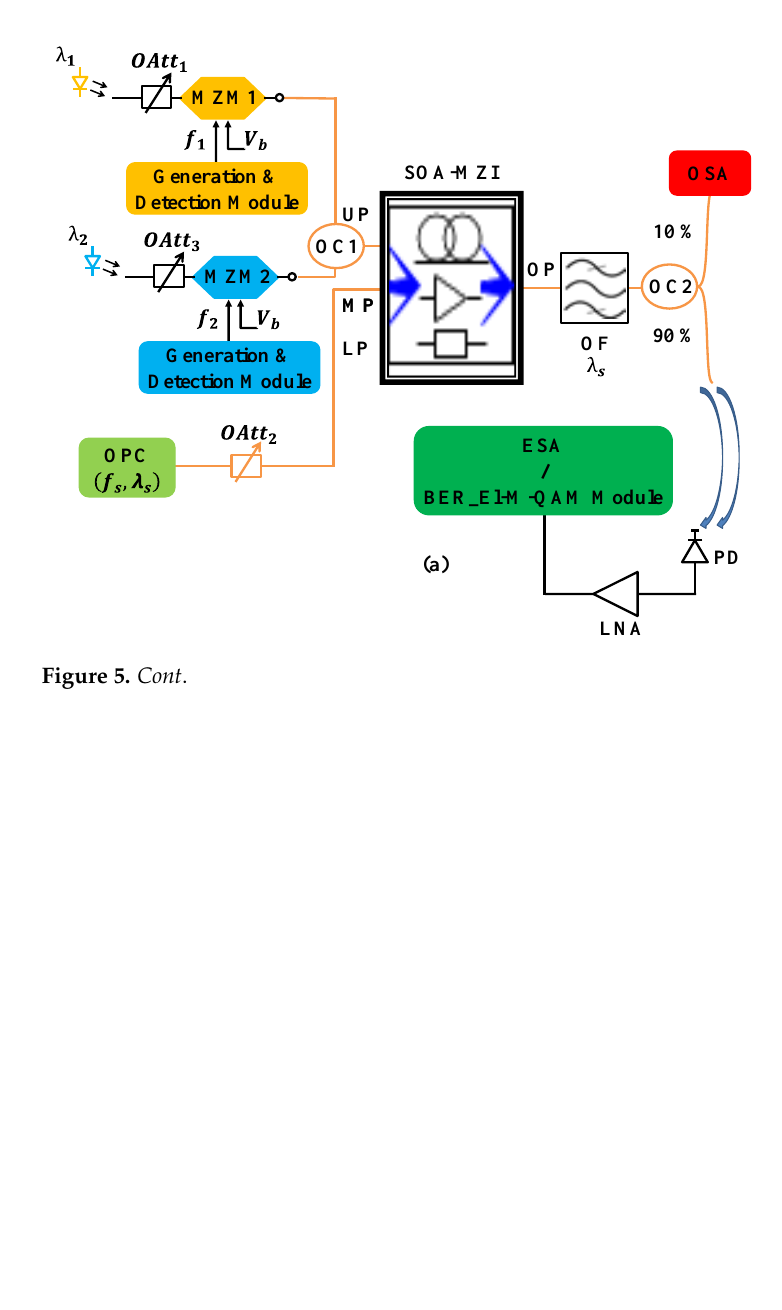
Figure 4. Dynamic characteristic of the SOA-MZI with the bandwidth of 8.5 GHz for the co-direction and 8.3 GHz for the counter-direction.